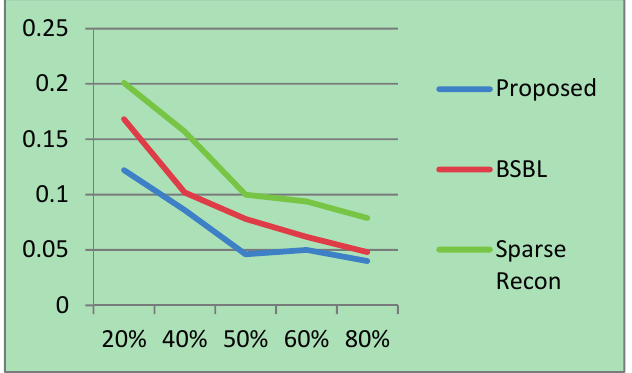
Figure 5. EEGLab dataset: NMSE on Y -axis, sampling/compression ratio on X